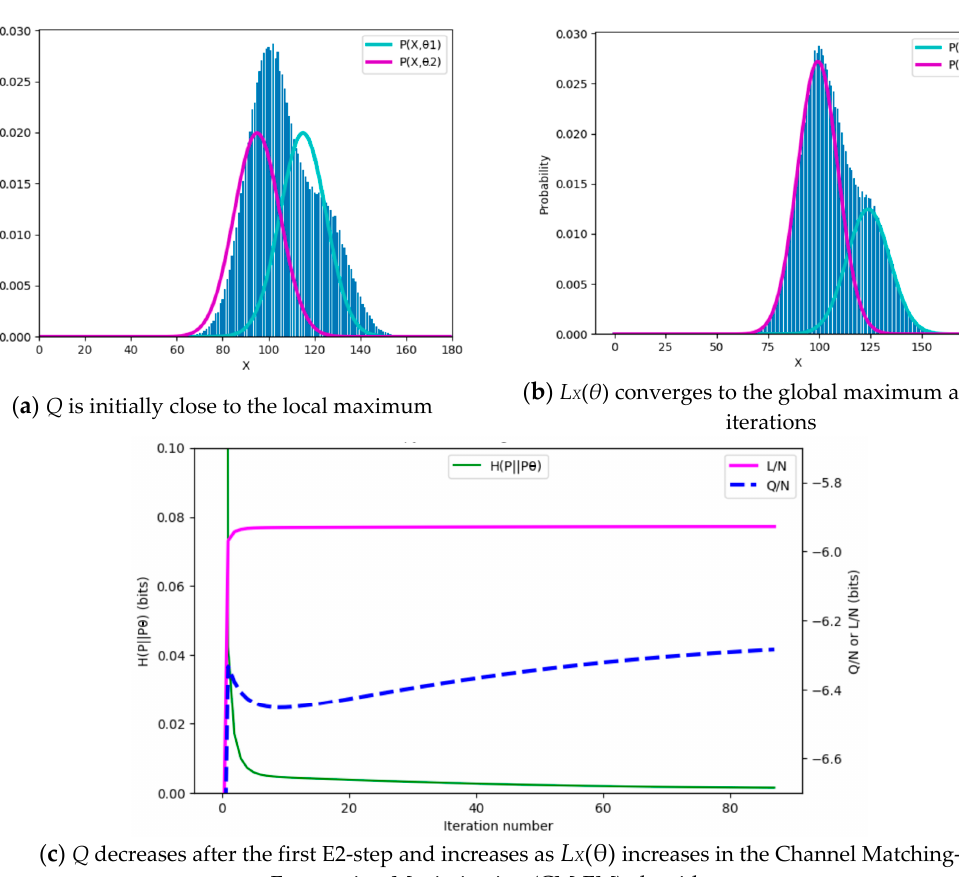
Figure 13. The iterative process from the local maximum of Q to the global maximum of L X ( θ ) . The stopping condition is when the deviation of every parameter is smaller than 1%. Information 2019 , 10 , x FOR PEER REVIEW